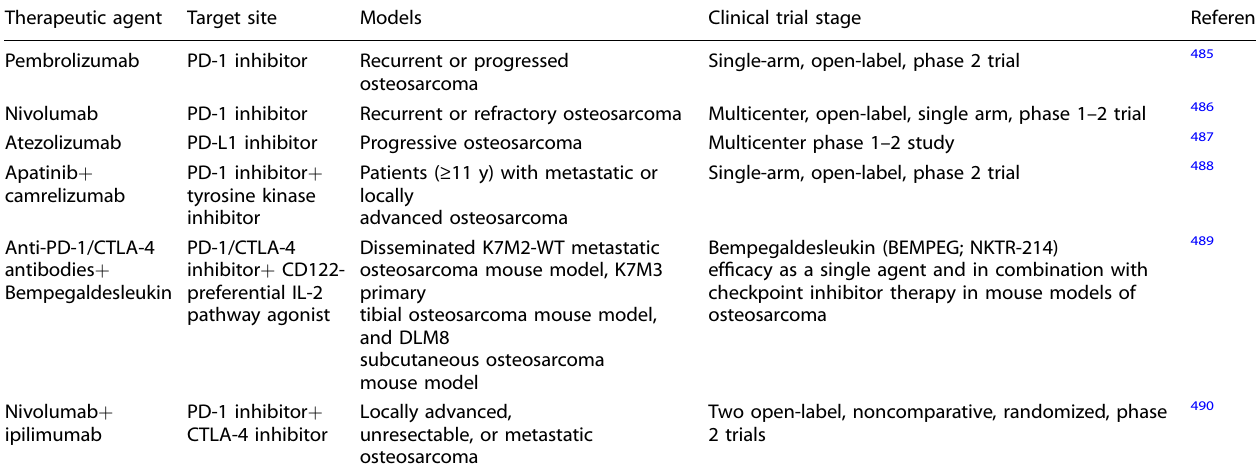
Table 4. Current immune checkpoint blockade therapies Therapeutic agent Target site Models Clinical trial